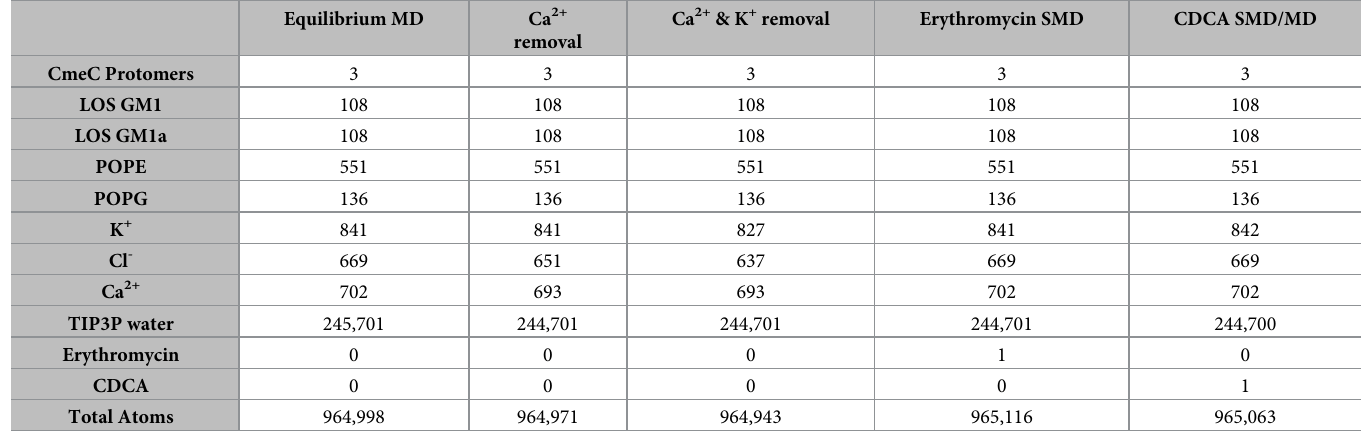
Three replicates of this system were generated. One simulation used the final frame of the 6th equilibration phase as the initial conformation. The additional replicates were each heated to 330 K for 20 ns with position restraints of 4,000 and 2,000 kJ mol -1 nm -2 applied to the protein backbone and sidechains respectively to induce new starting configurations for the membrane lipids. Each system was simulated at 315.15 K for 500 ns. Pressure was maintained at 1 bar using the semi-isotropic Parrinello-Rahman coupling scheme [115,116]. The contents of this system, and all subsequent simulation systems, can be found in Table 4. Table 4. Number of each species present in each simulation system. Equilibrium MD removal